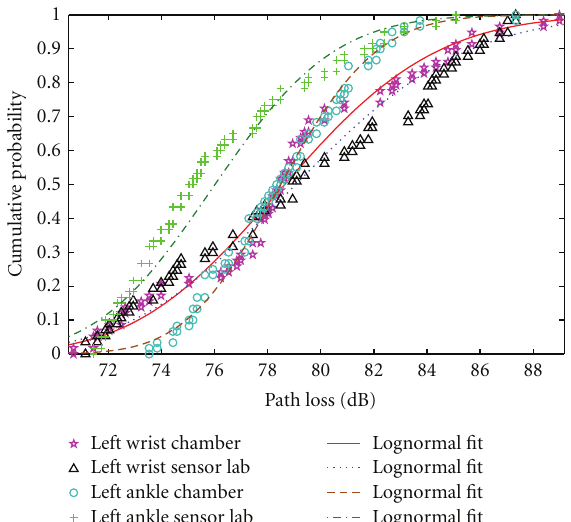
Figure 5: Cumulative distribution function of the left wrist and left ankle on-body radio channels when subject was walking measured in the chamber and in indoor environment.